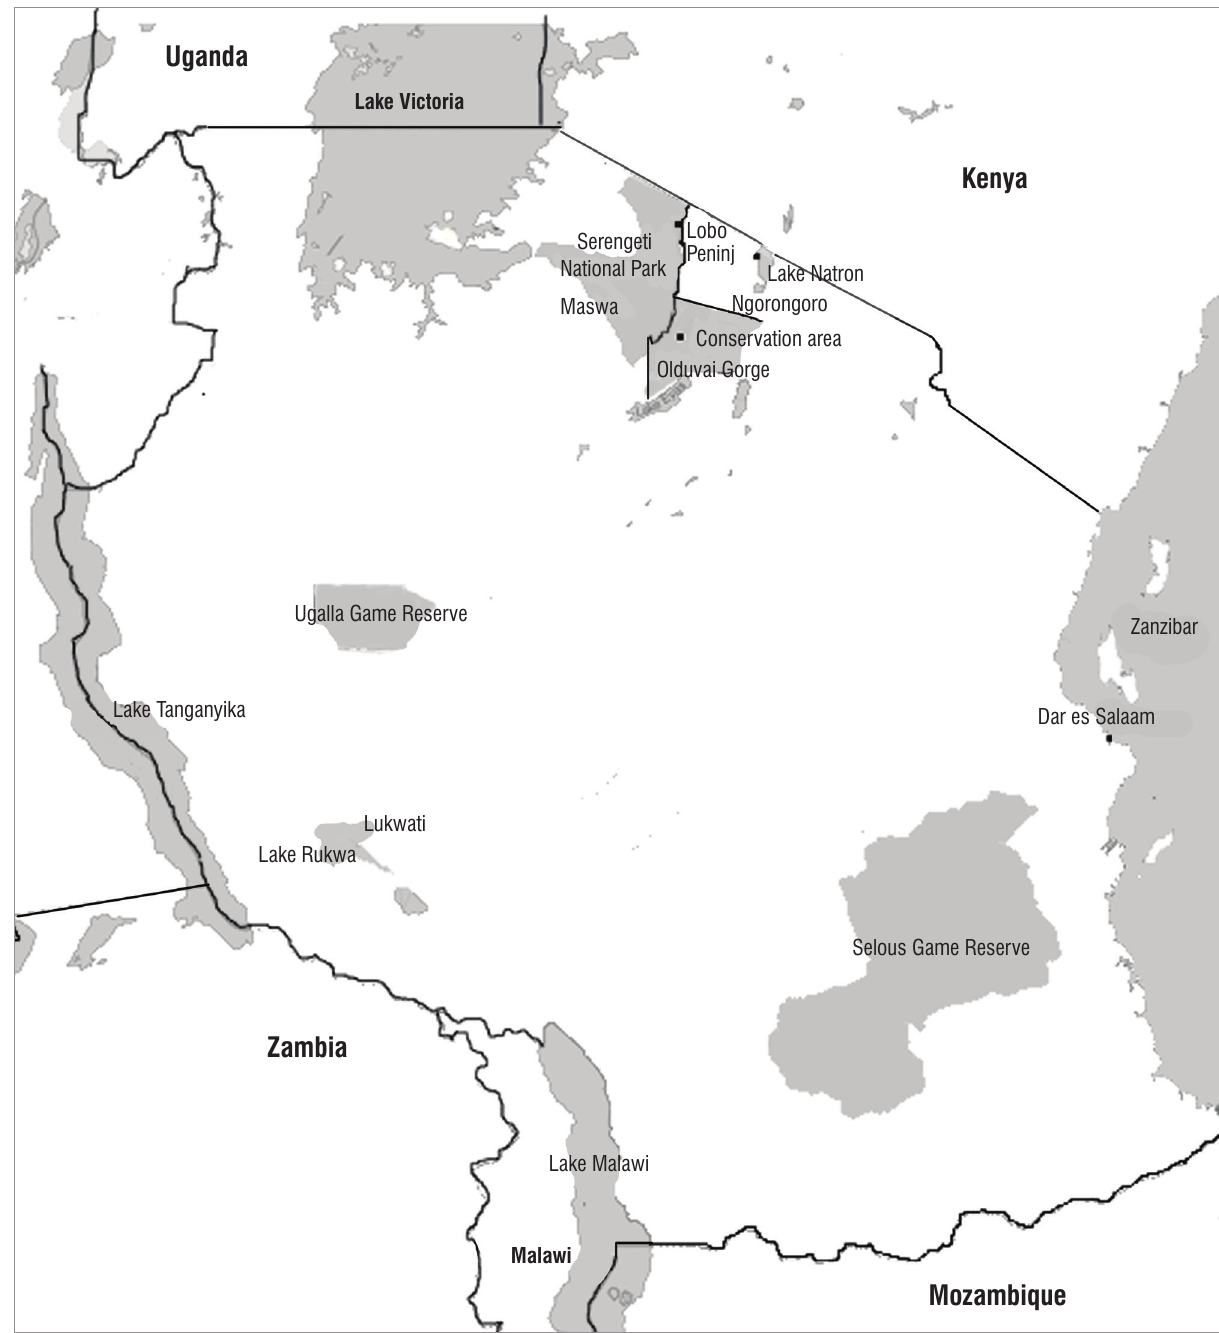
Figure 1: Map of Tanzania showing the six wildlife reserves from which modern faunal specimens were collected, as well as Olduvai and